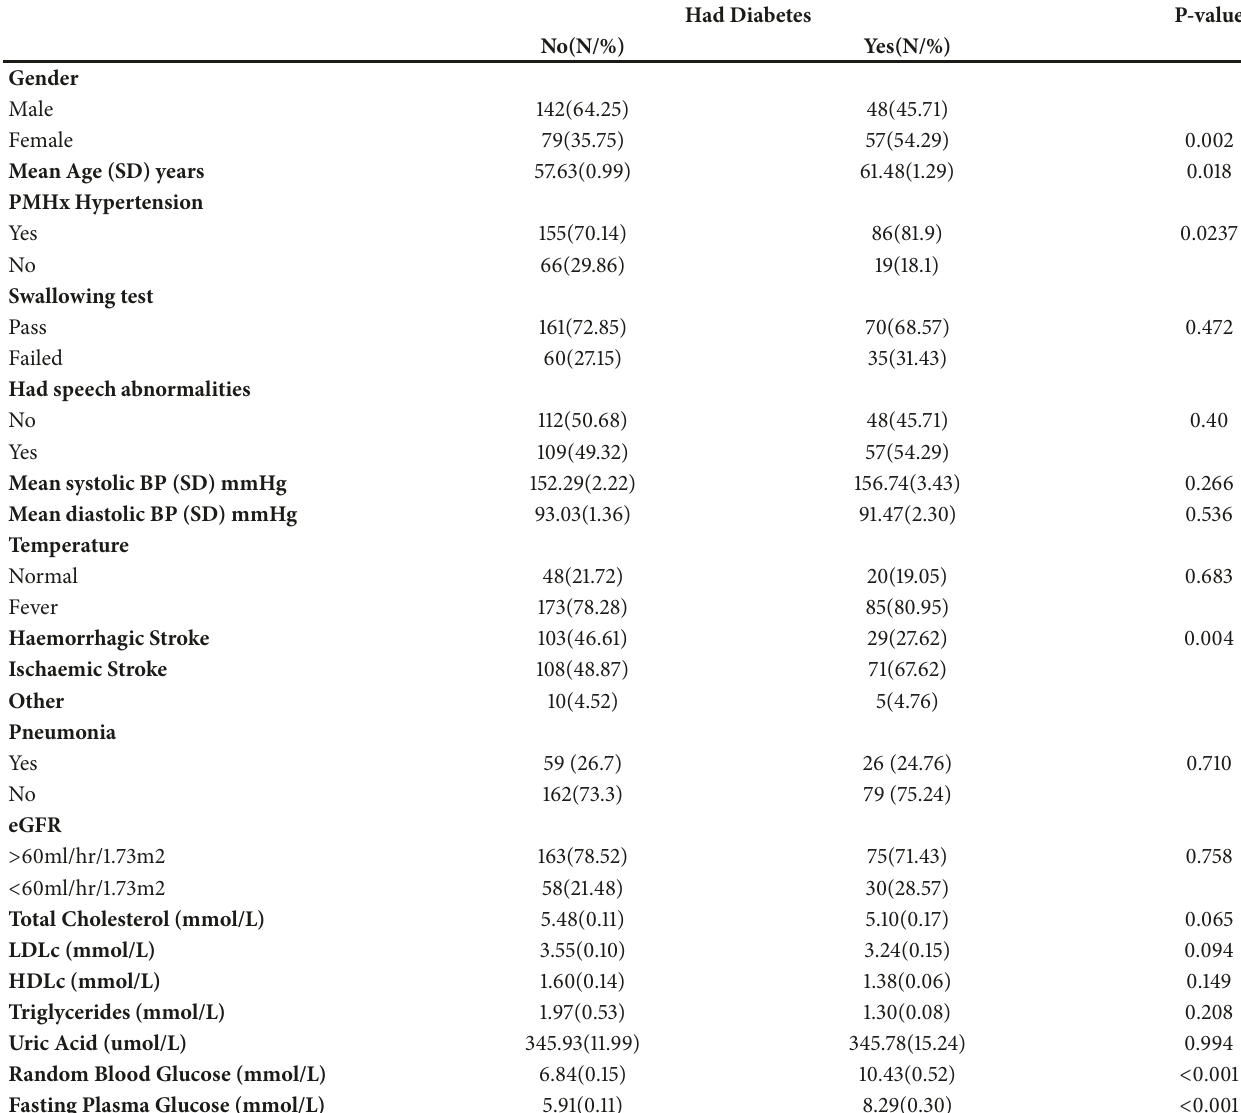
Table 1: Diabetes status versus baseline demographic and clinical characteristics among stroke patients admitted at Korle Bu Teaching